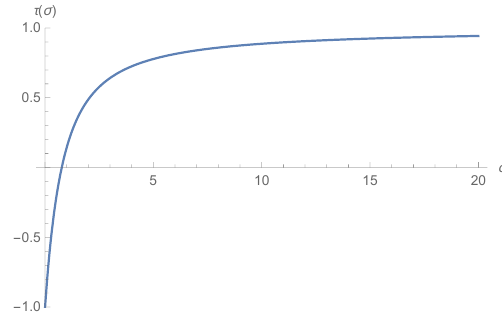
Figure 4: Lognormal Lorenz Copula Kendall’s τ LN as a function of σ